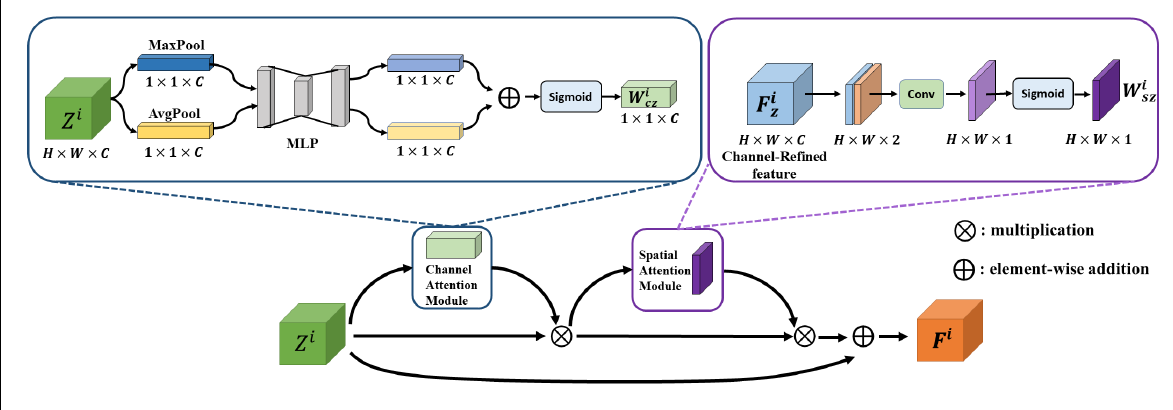
Figure 3. The Attention Model of Siamese